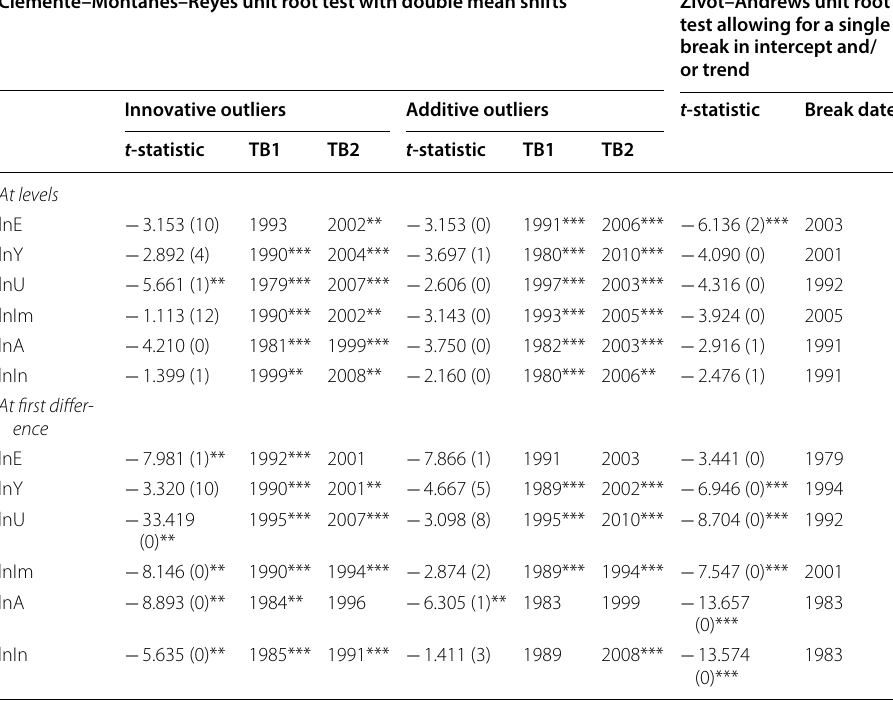
Statistically significant at 1% (***), 5% (**) and 10% (*) level